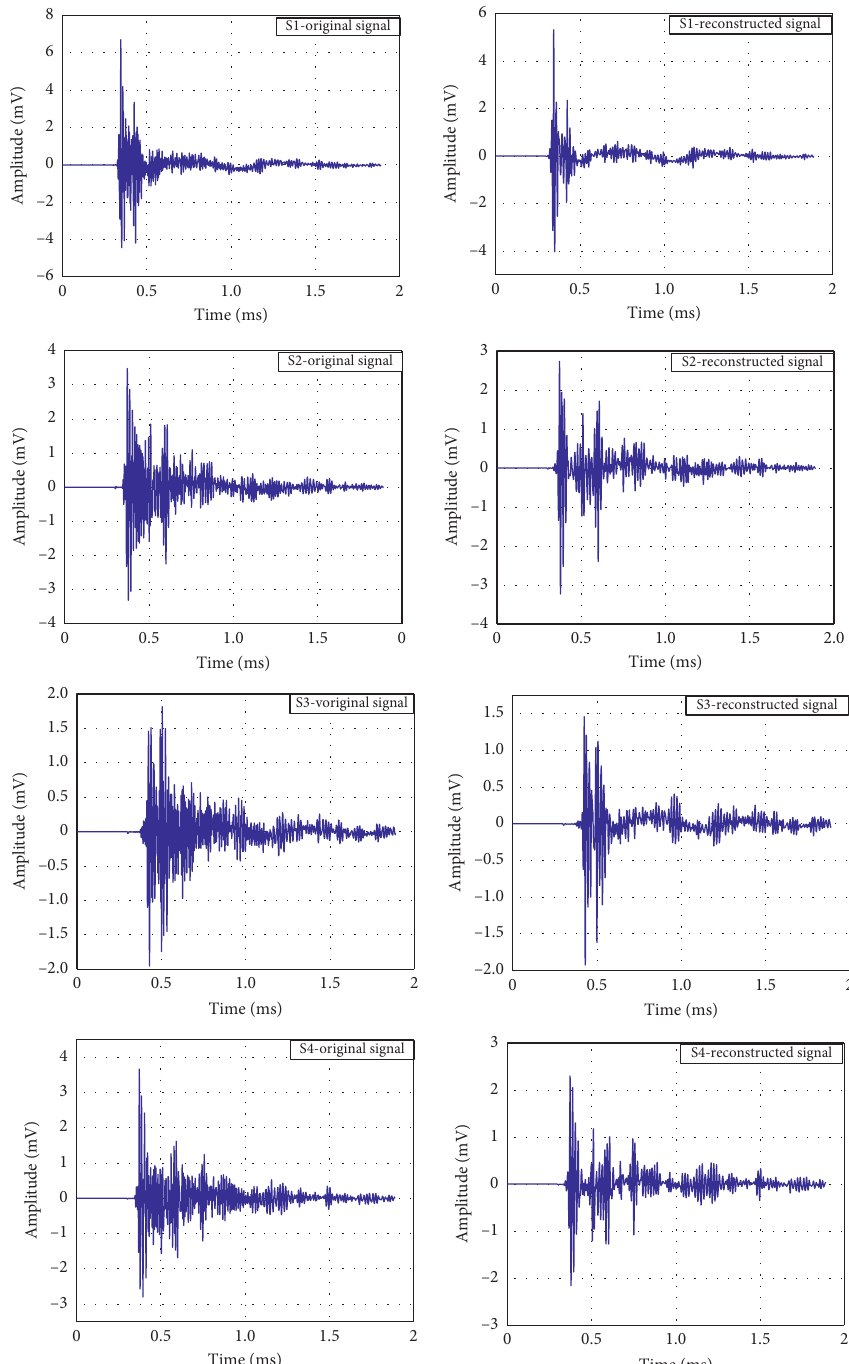
Figure 13: Original acoustic emission signal and reconstruction signal from the pulse source C1 received by S1, S2, S3, and S4